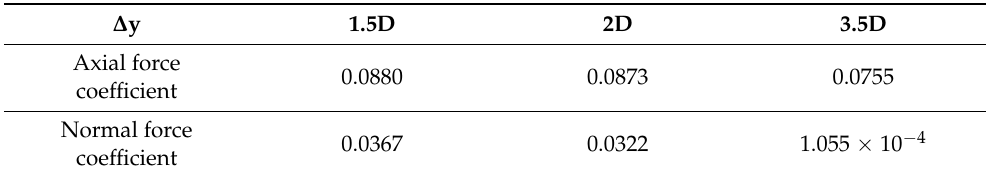
Table 4. Axial and normal force coefficients of side-by-side propulsion bottles when Ma = 3 and the altitude is 40